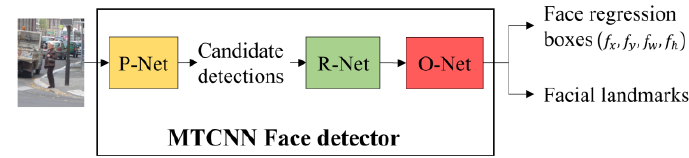
Figure 4. The diagram of the MTCNN face detector.